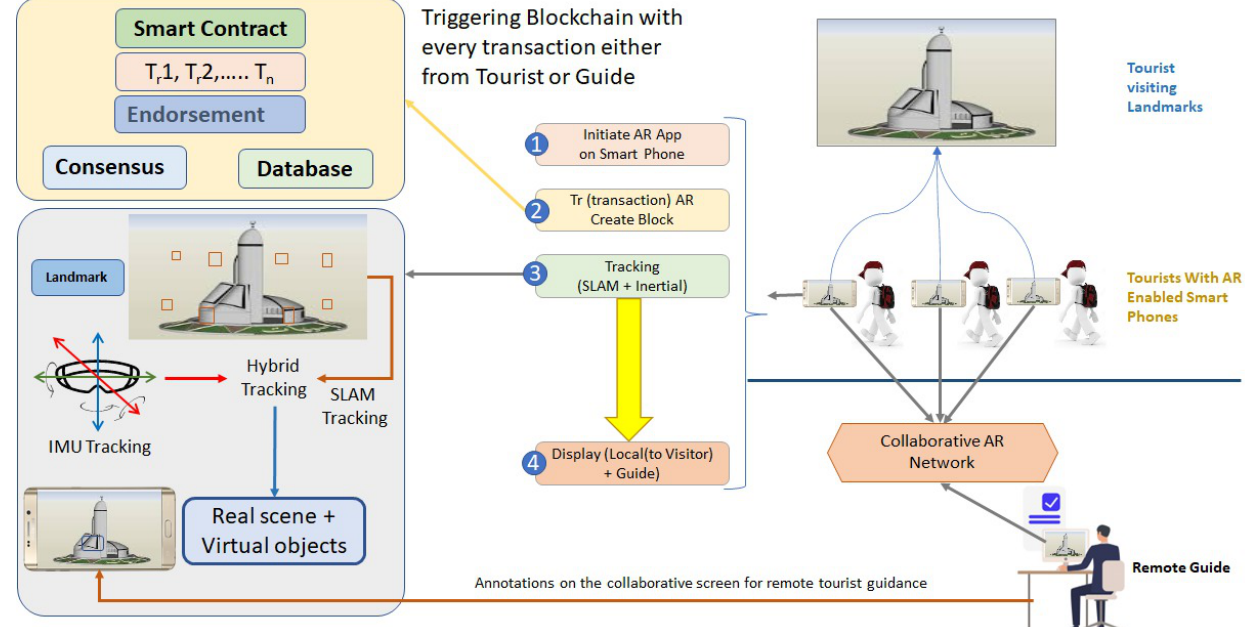
Figure 3. Sharing of the real-time environment of CAR-Tourist app for multiple users.